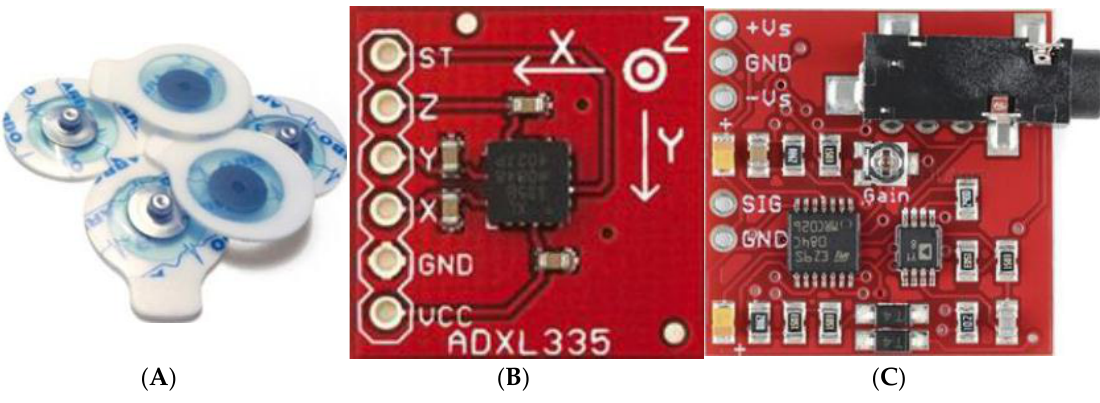
Figure 5. ( A ) Ag/AgCl electrodes; ( B ) the accelerometer; ( C ) the electromyography (EMG)